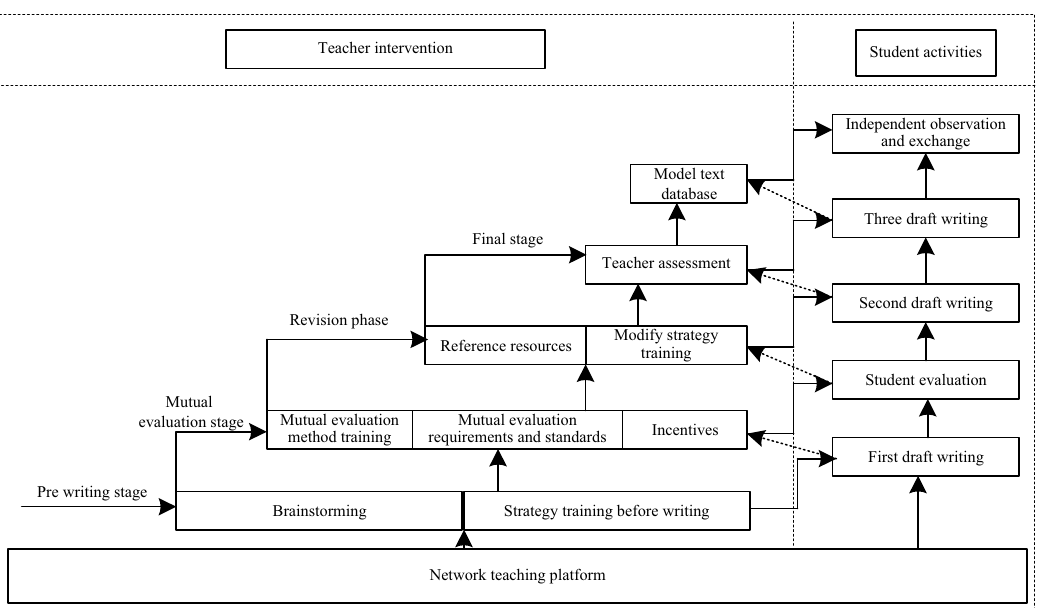
Figure 2: Structure of English dynamic assessment intervention